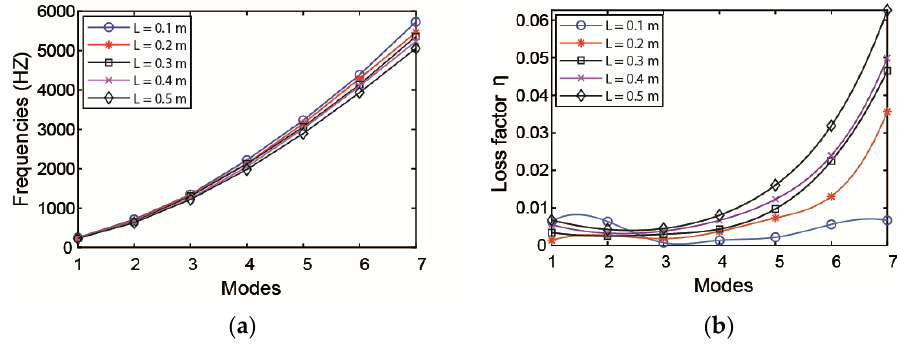
Figure 7. Influence of ACLD length on the ( a ) natural frequency and ( b ) loss factor.